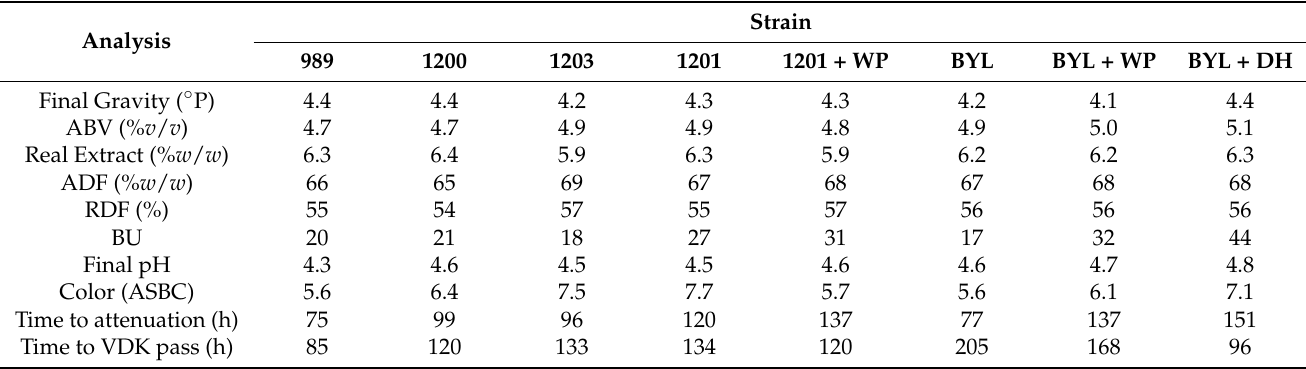
Table 2. Finished beer chemistry and fermentation